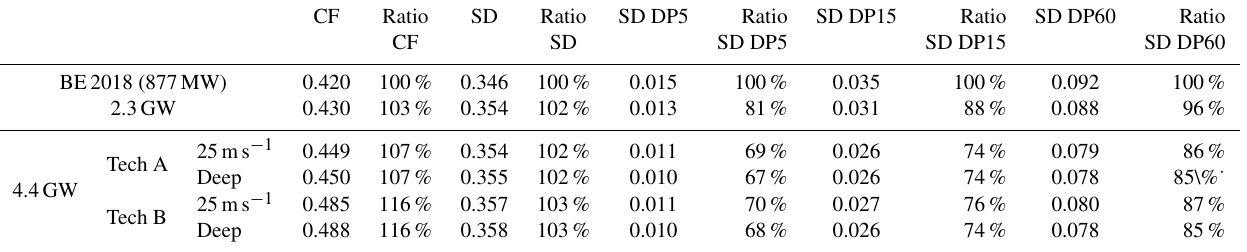
Table 4. Capacity factors (CFs), standard deviation of standardized power (SD), and standard deviations of power ramps in 5, 15, and 60min (SD DP5, SD DP15, SD DP60) and their relative ratios with respect to BE2018. All statistics are computed over the 37 years of